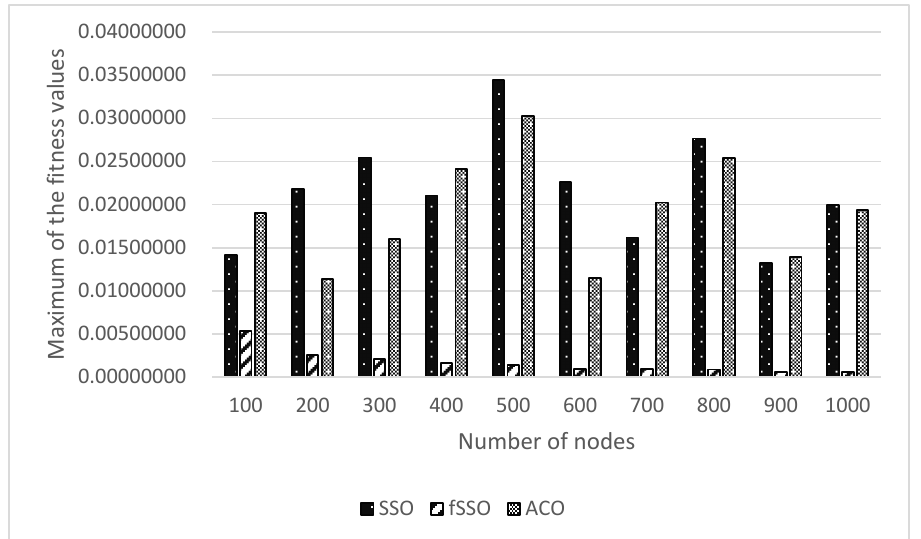
Figure 7. Minimum of the fitness values for ten benchmarks.